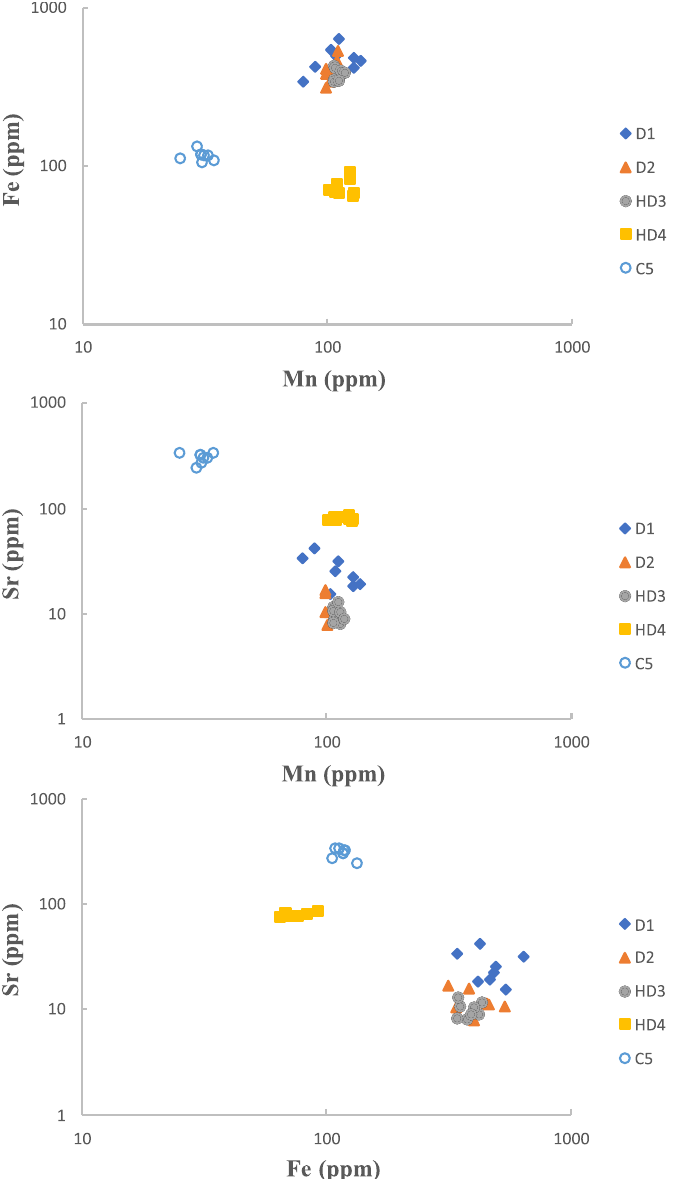
Figure 11. Plots of LA-ICP-MS data from carbonate depicting relative changes in Mn, Fe, and Sr in the Fuli Pb-Zn deposit.